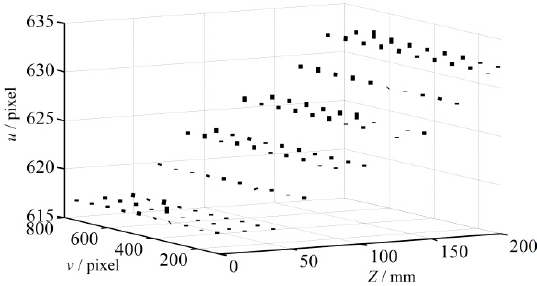
Figure 9. Blue error map of the slice in Figure 8.